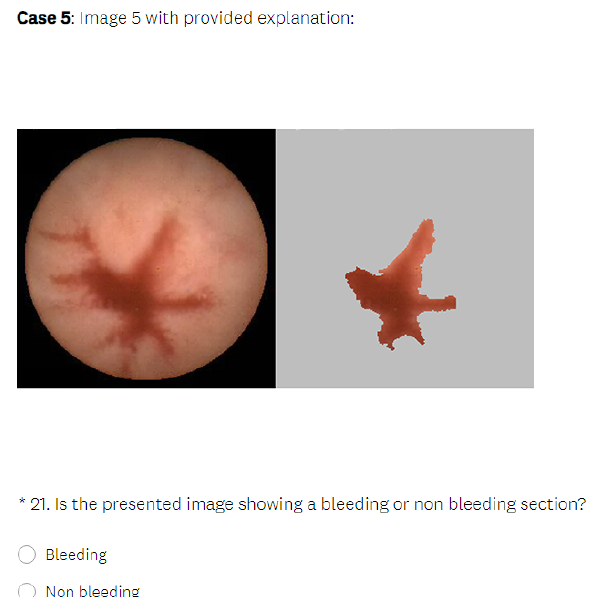
Figure 15. CIU explanations in the user study.